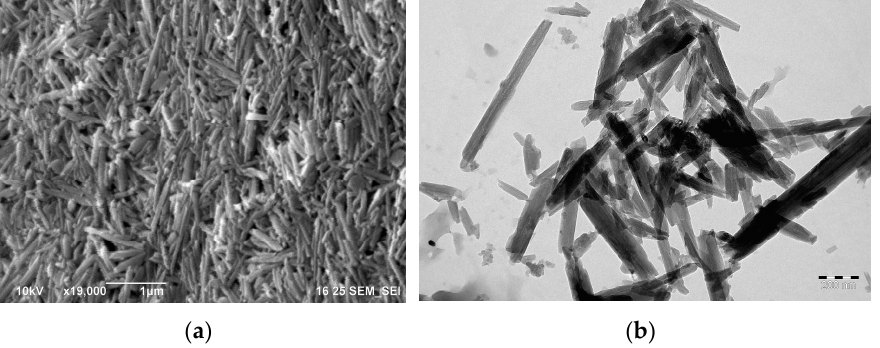
Figure 3. ( a ) SEM micrograph of halloysite nanotubes. Scale bar, 1 µm; ( b ) TEM micrograph of halloysite nanotubes. Scale bar, 200 nm. halloysite nanotubes. Scale bar, 200